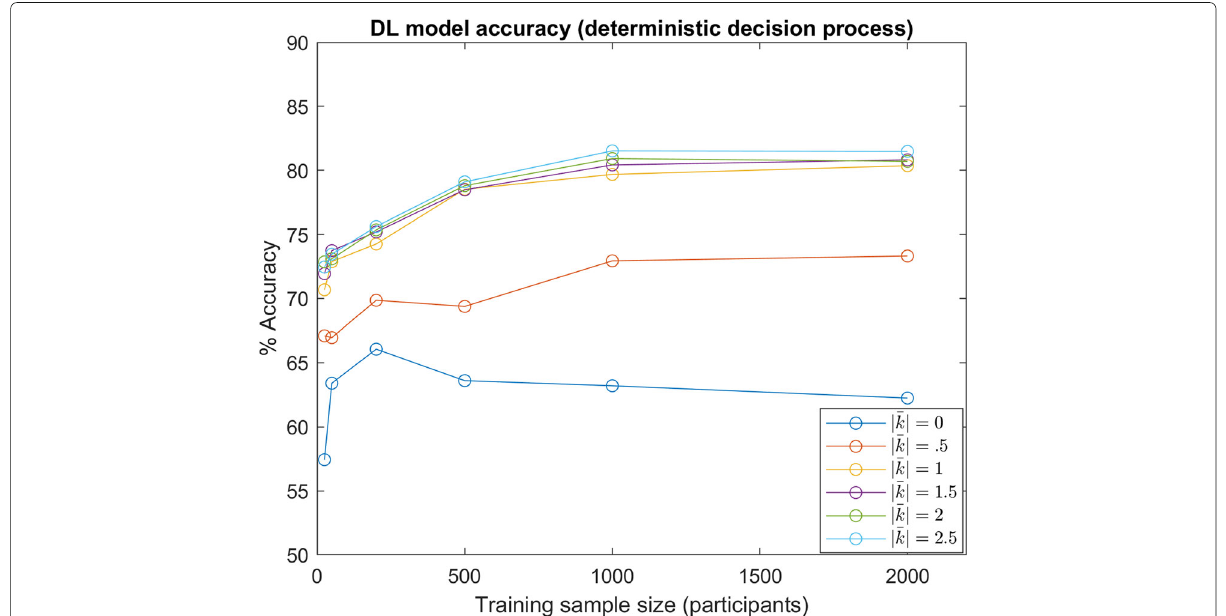
Fig. 14 DL Model Accuracy (Generated; Deterministic Process): DL model predictive accuracy with different sample sizes and underlying distributions of w , applied to the generalized, abstract data. Various distributions for w are denoted by the approximate average of absolute shape (cid:14) (cid:14) (cid:14) = 0 denotes the Gaussian distribution) In this test, decisions were simulated with deterministic version of Eq. 2 (cid:14) ¯ k factors k (